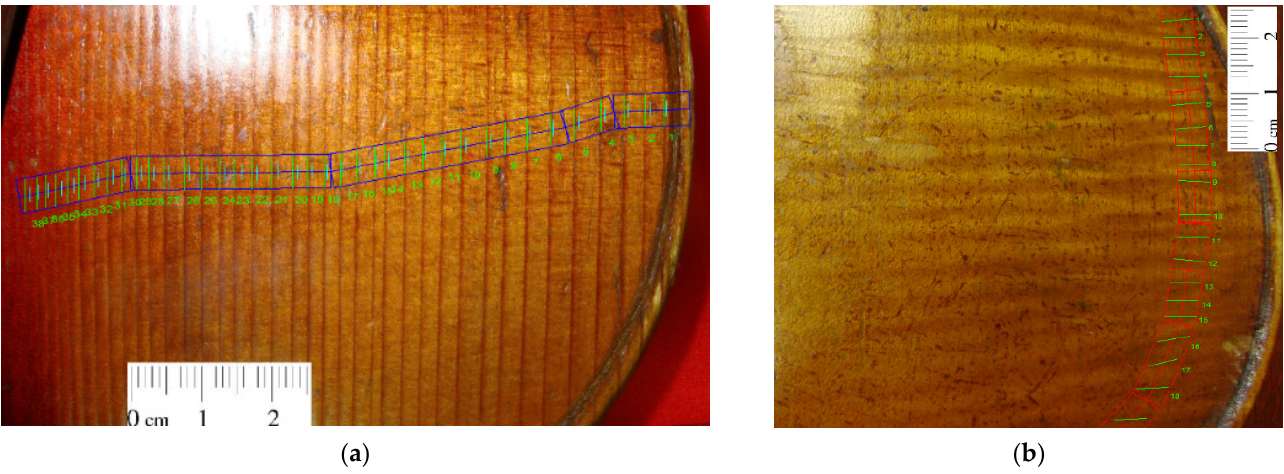
Figure 4. The constructive principle of violin boards for obtaining the anatomical symmetry of the wood structure: ( a ) measurement of annual rings, early wood–late wood with Windendro system 2007 in case of violin top plate; ( b ) measurement of wavelength with Windendro system 2007 in case of violin back plate.